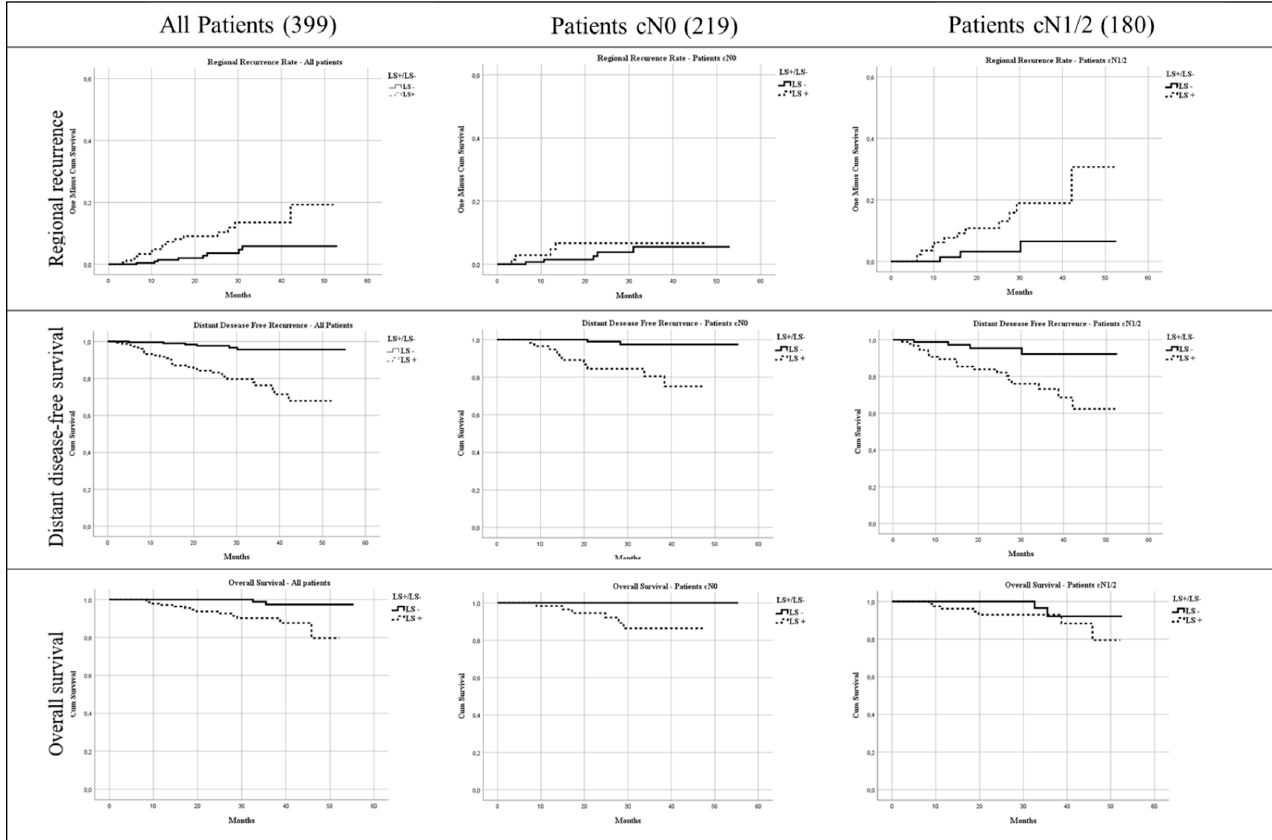
Figure 2. Cumulative Overall Survival, Regional Recurrence and Distant Disease Free Survival. At uni- and multivariate analysis (Table 5), positive SLN was confirmed as an inde- pendent prognostic factor for DDFS, as well as triple negative immunophenotype and T pathological complete response, even in the cN0-ycN0 and in the c1/2-ycN0 group. Table 5. Univariate and multivariate analysis for Distant Disease Free Survival.